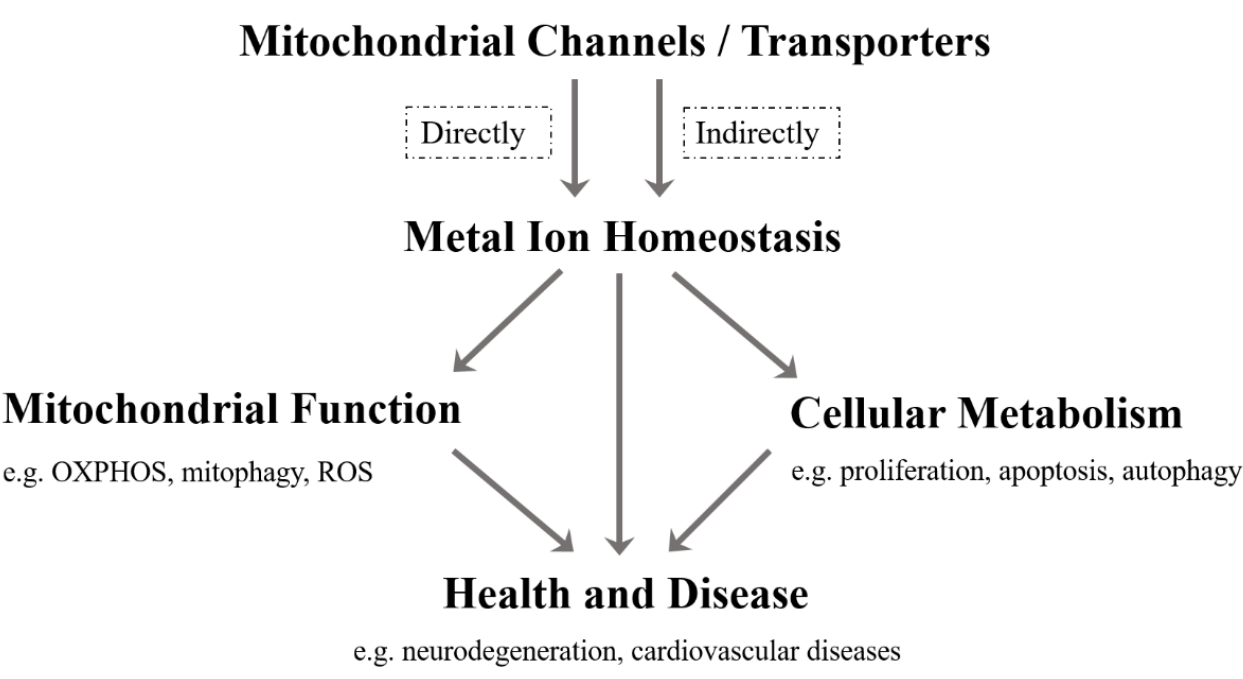
Figure 1. Mitochondrial channels/transporters transport various kinds of metal ions, which directly or indirectly regulates the homeostasis of metal ions. The metal ion homeostasis is essential for mitochondrial function, cellular metabolism, health and disease.